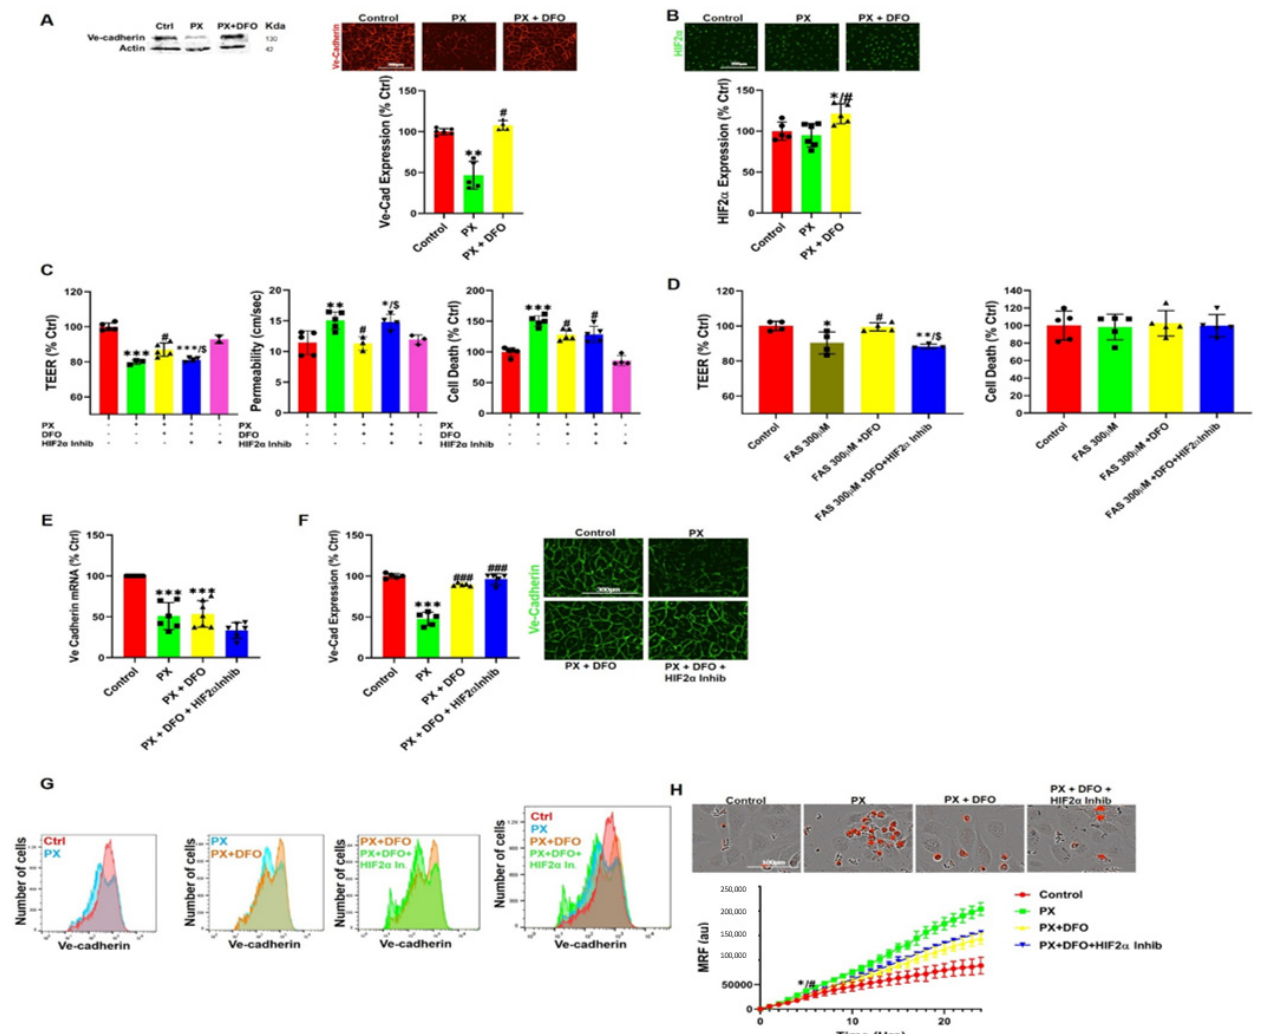
Figure 4. DFO rescues BBB Permeability via a HIF2 α -Ve-cadherin pathway. ( A ) Ve-Cadherin expression was measured with western blotting and immunocytochemistry intensity quantification in a BLEC monolayer treated with 400 µ M PX for 24 h. DFO was added at 50 µ g/mL. Ctrl are cells cultured with normal medium without the addition of any treatments. Mean ± s.d. of one representative experiment is shown, out of four independent experiments with n = 16–24, ** p < 0.01 vs. ctrl and # p < 0.05 vs. PX. Scale bar = 200 µ m; ( B ) Immunofluorescence staining and quantification of HIF2 α in a BLEC monolayer treated with PX. Mean ± s.d. of one representative experiment is shown, out of four independent